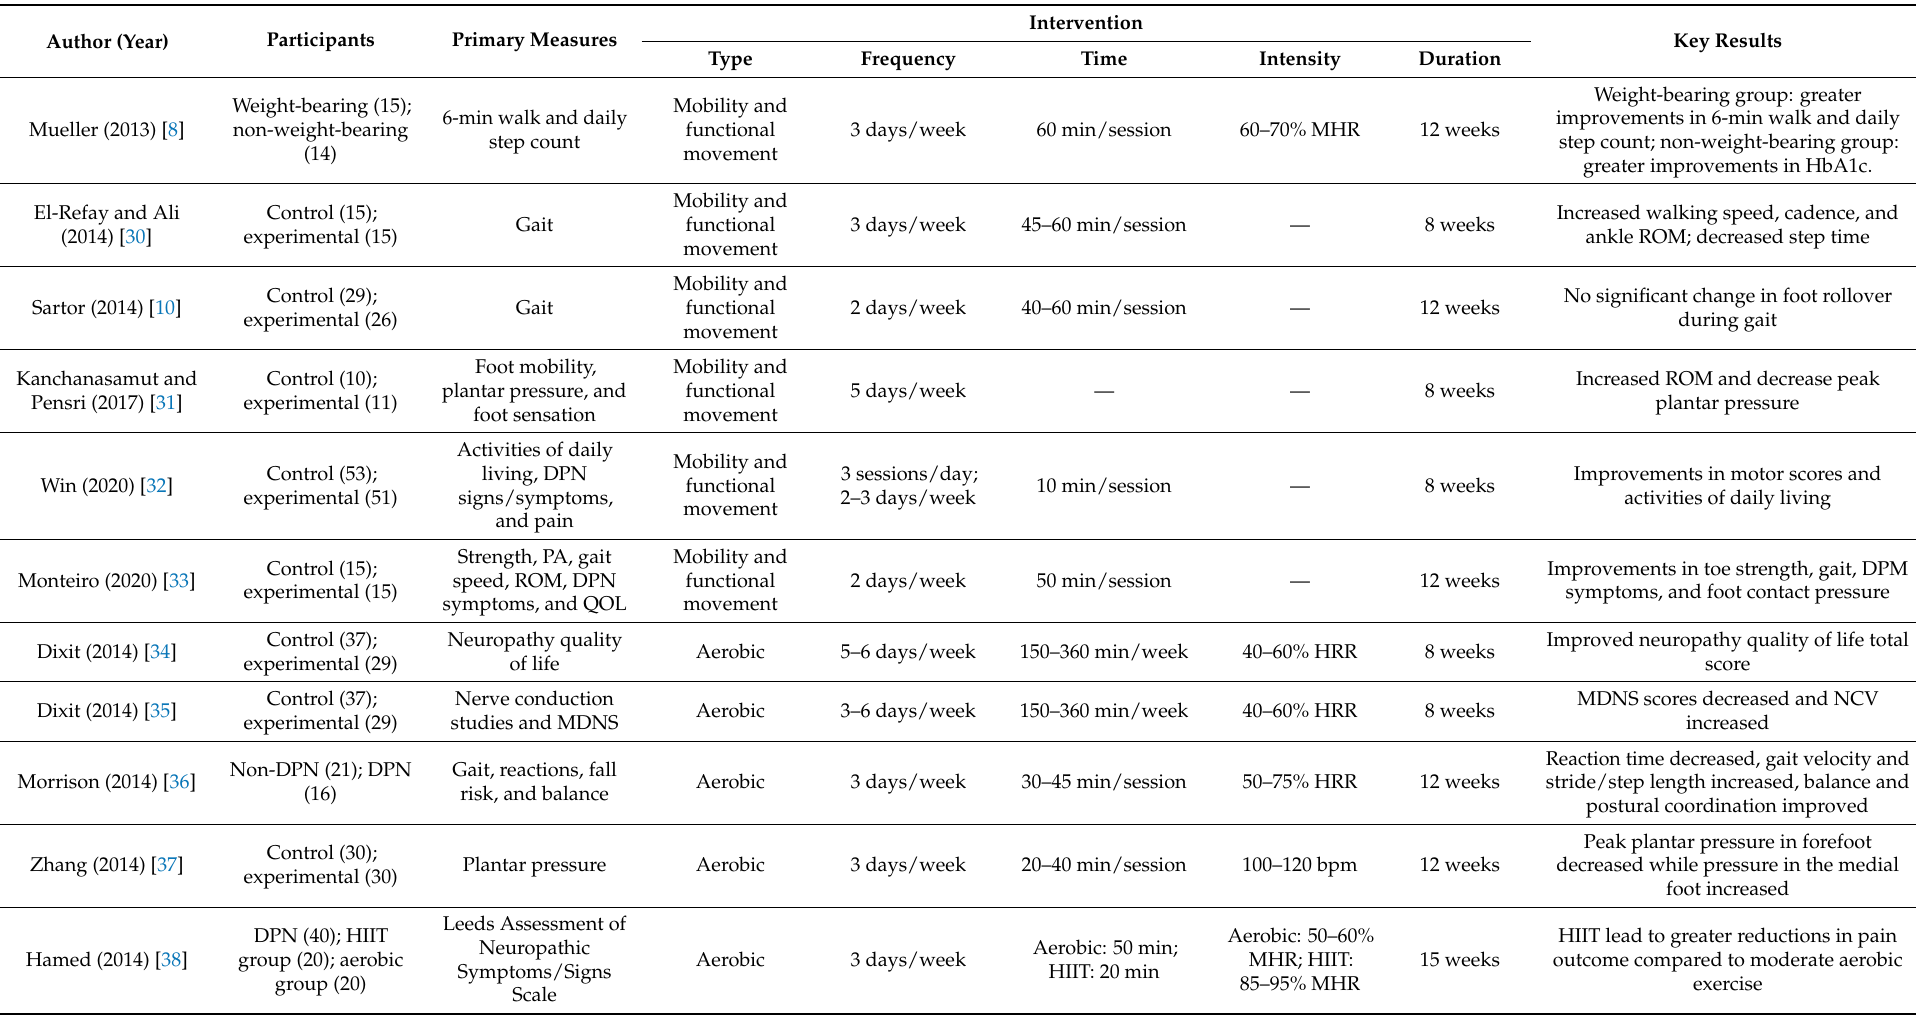
Table 1. Summary of exercise training intervention studies in individuals with diabetic peripheral